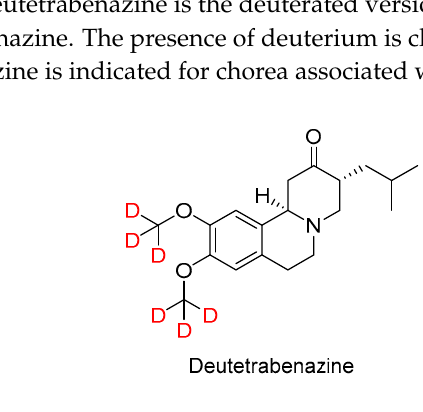
Figure 4. Structure of deutetrabenazine.